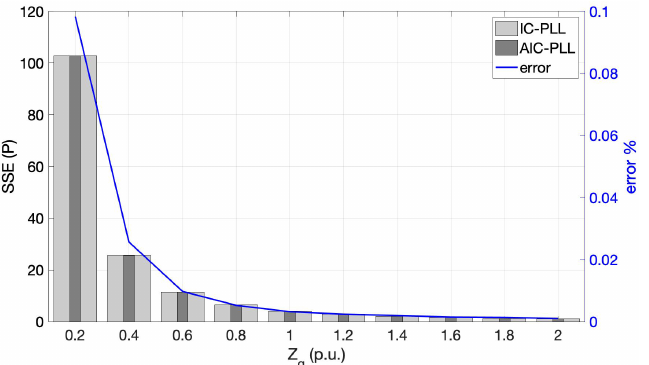
Figure 17. SSE for the active power tracking for the IC-PLL- and AIC-PLL-based system for the maximum power (rectifier